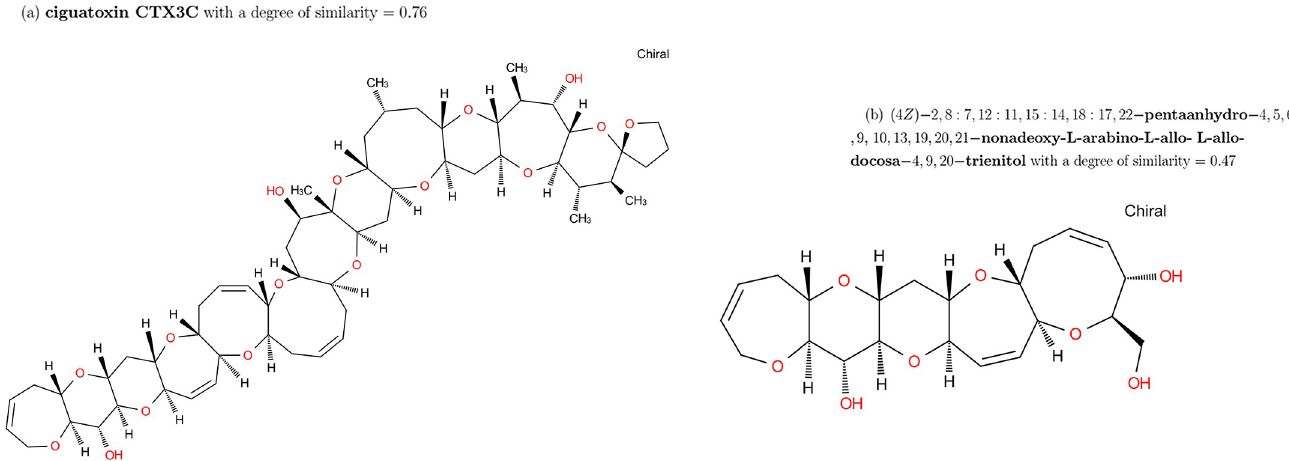
Fig 13. Results of similarity for Brevetoxine A on GC. (a) Ciguatoxin CTX3C with a similarity of 0.76 (b)(4Z)-2,8:7,12:11,15:14,18:17,22-pentaanhydro- 4,5,6,9,10,13,19,20,21-nonadeoxy-L-arabino-L-allo-L-allo-docosa-4,9,20-trienitol with a similarity of 0.47. These two molecules share a structural part with Brevetoxin